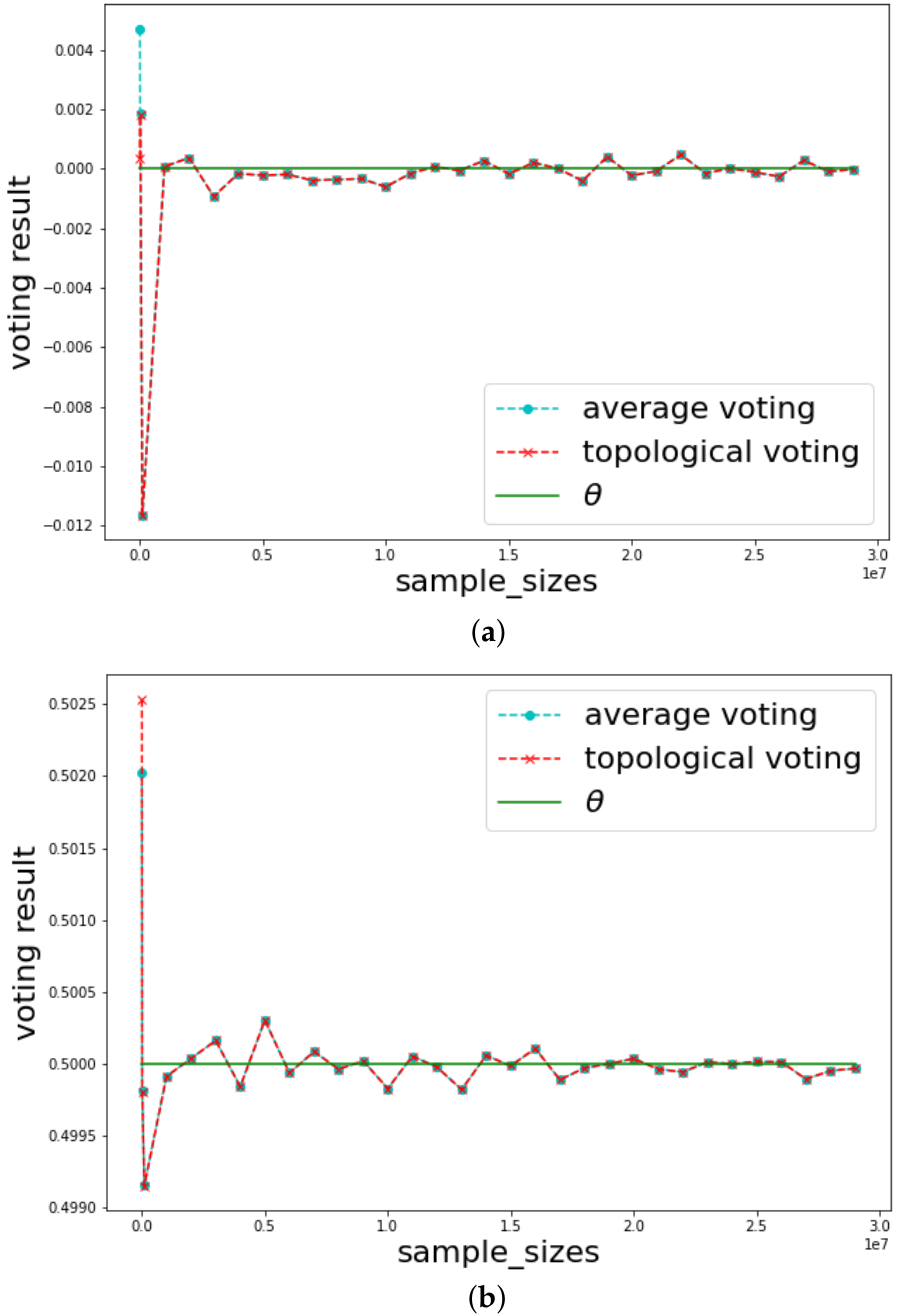
Figure 11. Comparisons of arithmetical voting (average voting) and topological voting method in one dimension setting. ( a )